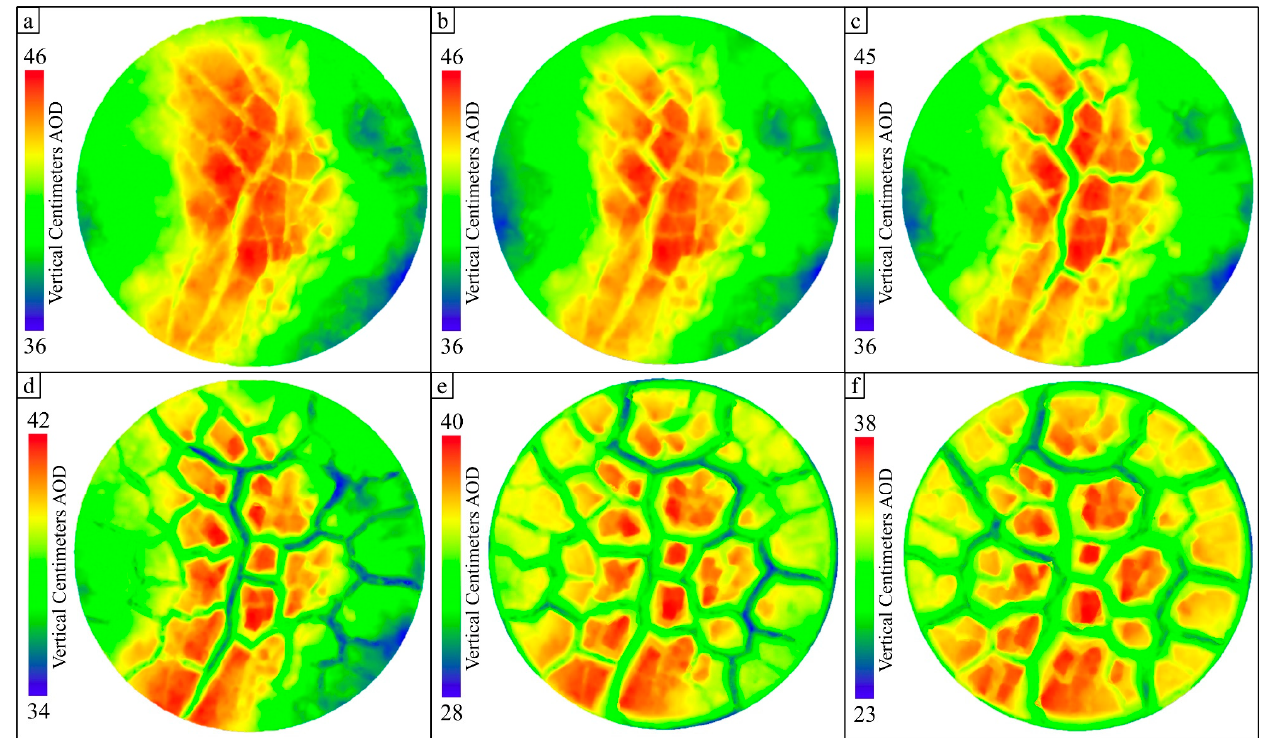
Figure 7. Digital-elevation models of the soil surface during shrinkage: ( a ) day 10; ( b ) day 18; ( c ) day 40; ( d ) day 68; ( e ) day 111; and ( f ) day 143. Table 2. Summary of maximum crack depths calculated using digital-elevation models.